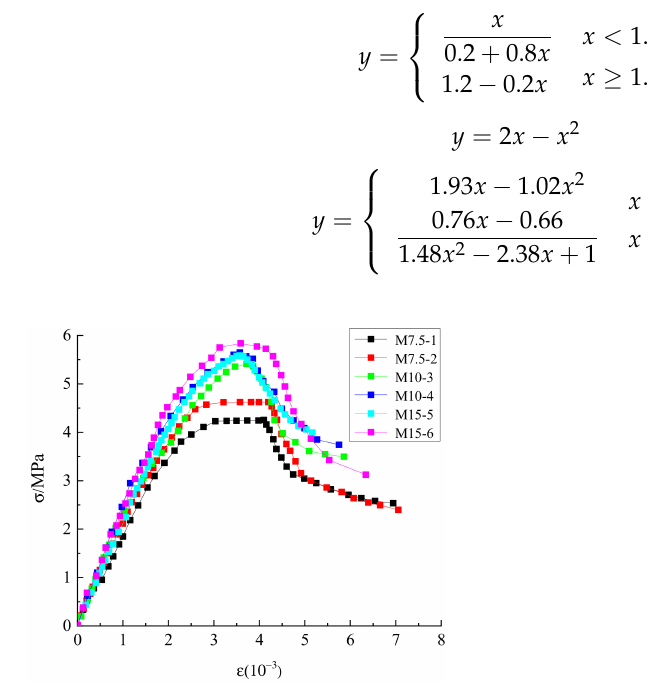
Figure 5. Stress–strain curves.